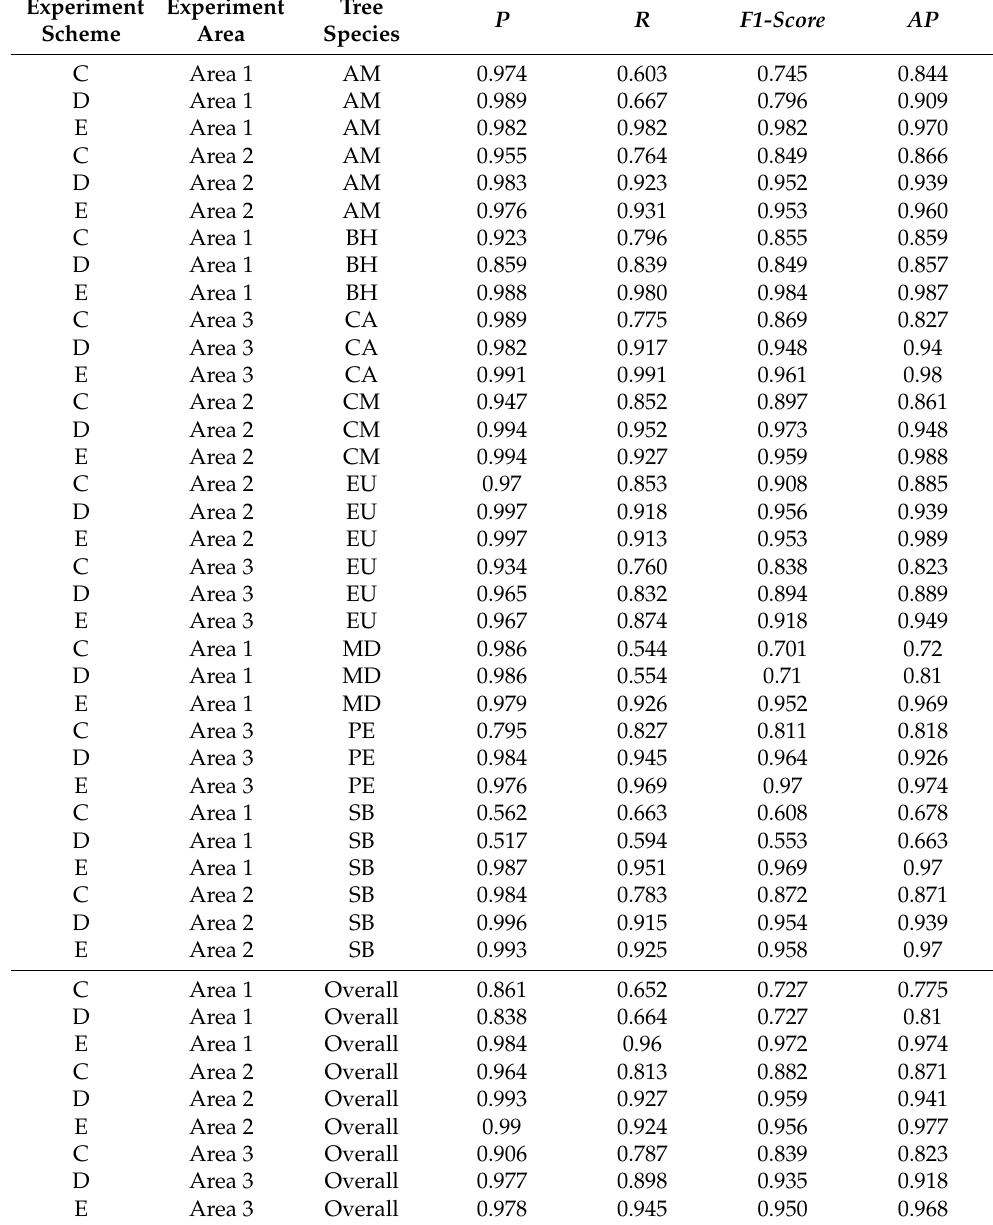
Table 7. Accuracy evaluation of individual tree species identification with different edge detection